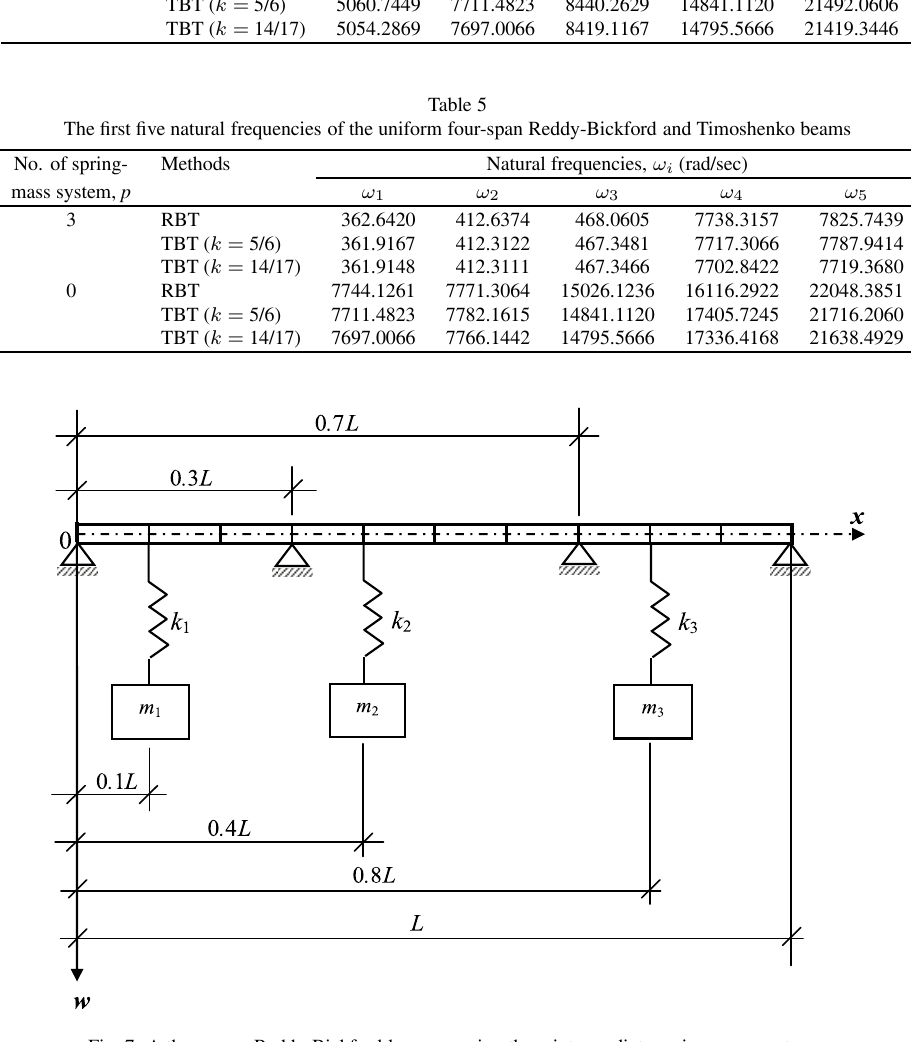
Fig. 7. A three-span Reddy-Bickford beam carrying three intermediate spring-mass